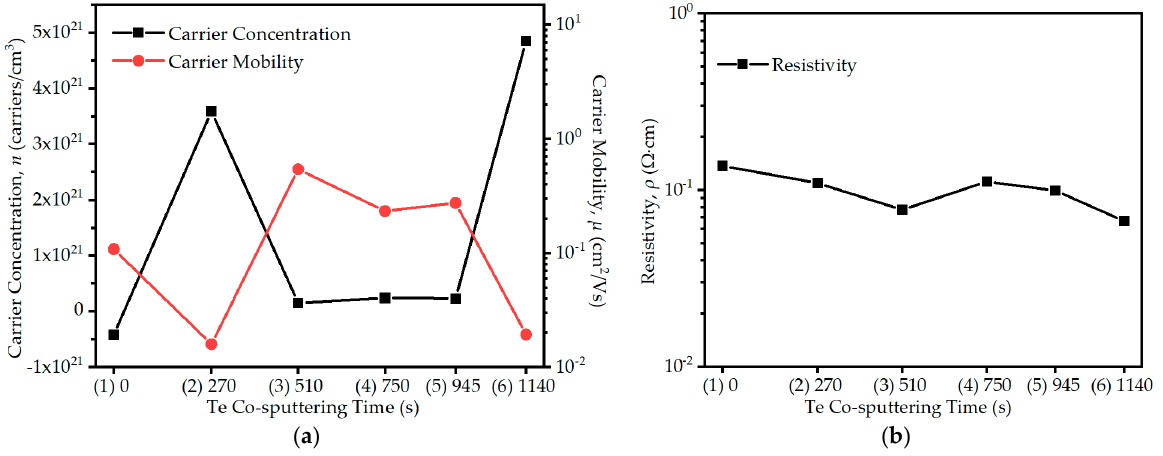
Figure 6. ( a ) Carrier concentration ( n ), carrier mobility ( μ ), and ( b ) resistivity ( ρ ) in the CIGS:Te thin films with different Te co-sputtering times of (1) 0, (2) 270, (3) 510, (4) 750, (5) 945, and (6) 1140 s.